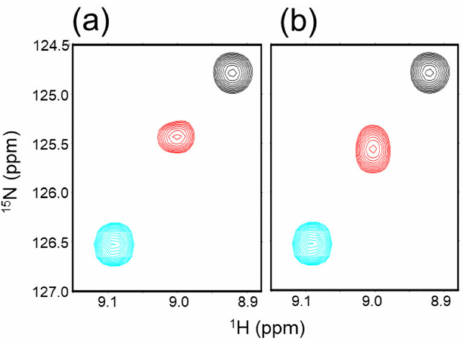
Figure 4. Possible effects of artificial linking of Ub units. 1 H- 15 N HSQC peaks originating from Val70 of uniformly 15 N-labeled ( a ) K48C-diUb EA (red) and ( b ) K48C-diUb (red). The peaks from monomeric Ub and c-diUb are shown in cyan and black, respectively. The spectra were measured at 25 ◦ C in 10 mM sodium phosphate buffer, pH